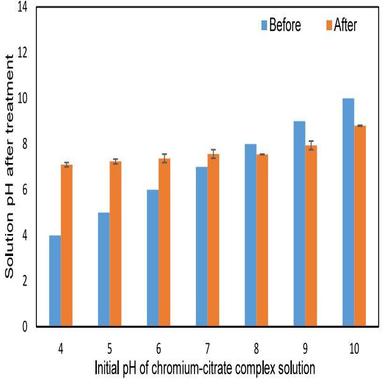
The variation pH value during treatment.